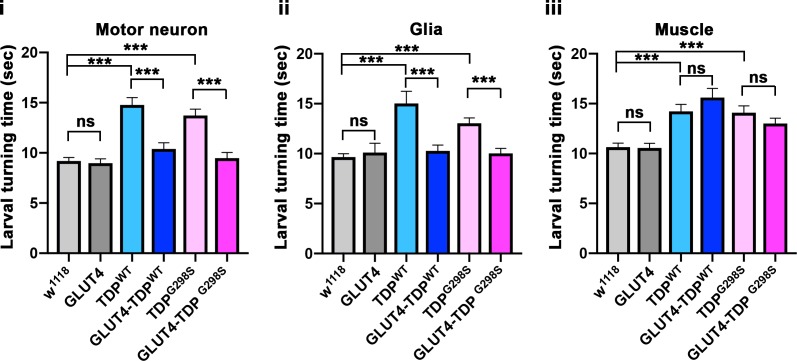
Larval turning assays for GLUT-4 and TDP-43 overexpression in motor neurons (i), glia (ii) or muscles (iii).Genotypes as indicated. N = 30 larvae. Kruskal-Wallis test was used to determine statistical significance.10.7554/eLife.45114.020Figure 4—figure supplement 5—source data 1.GLUT 4 Glia LT; GLUT4 MN LT; and GLUT4 Muscle LT.